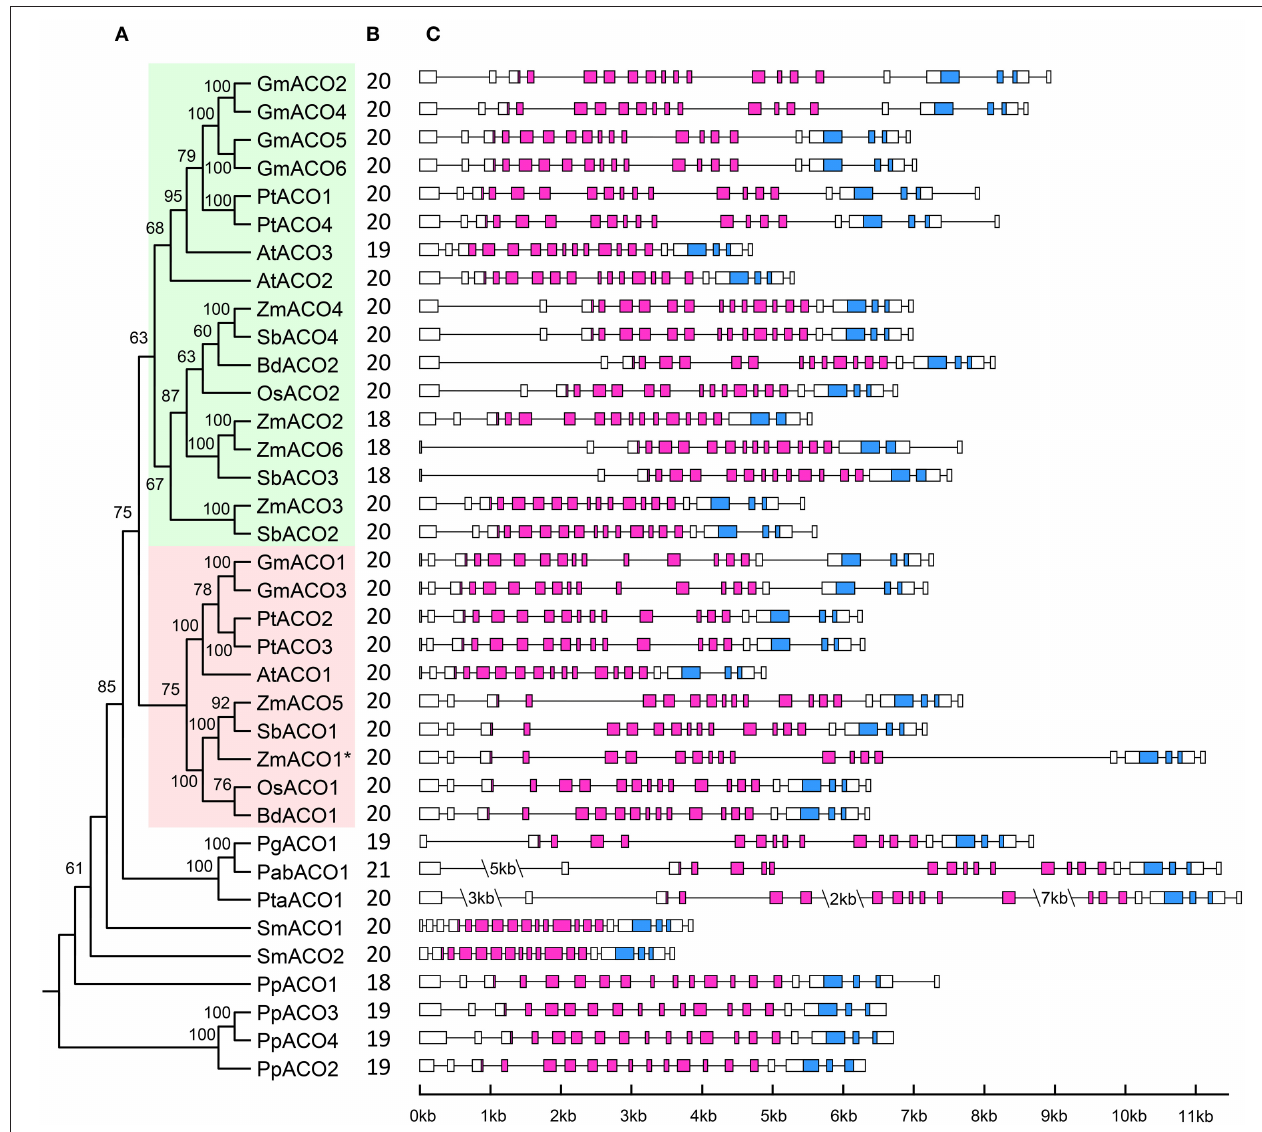
FIGURE 7 | Phylogenetic relationships and Gene structure of ACO gene family in land plants. (A) The phylogenetic relationships of ACO genes, clade A1, and clade A2 are shaded in green and red, respectively. Putative pesudogene is marked with an asterisk. (B) Exon number of corresponding ACO genes. (C) Gene structure of ACO genes. AcnA_IRP domain and AcnA_IRP_Swivel domain are highlighted by the purple and blue boxes, respectively; introns are indicated as